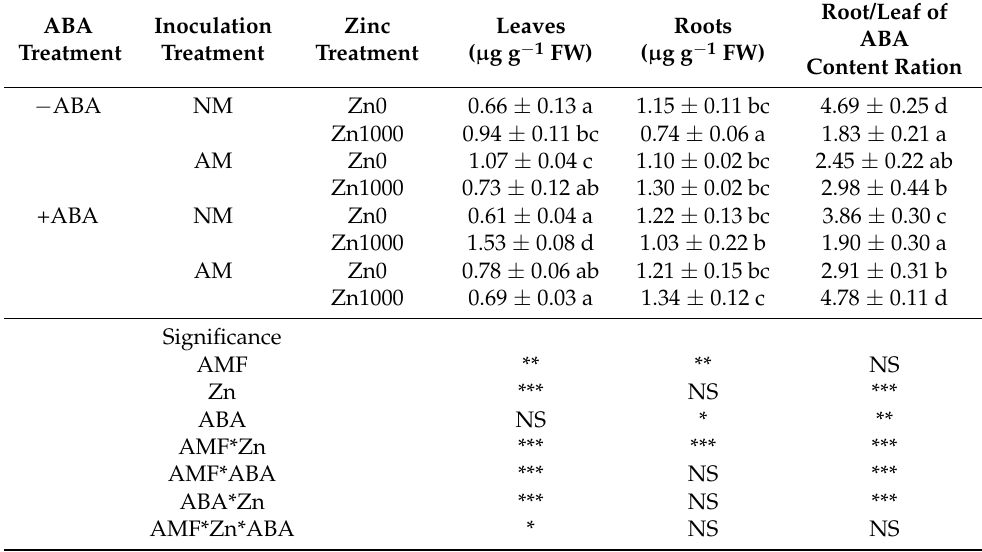
Table 1. The ABA concentrations in the leaves and roots and the root/leaf to ABA content ratio. ABA Inoculation Treatment